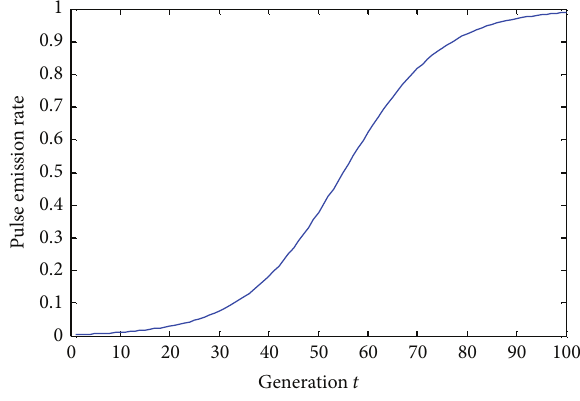
Figure 2: Updating curve of pulse emission rate 𝑟 𝑖 .